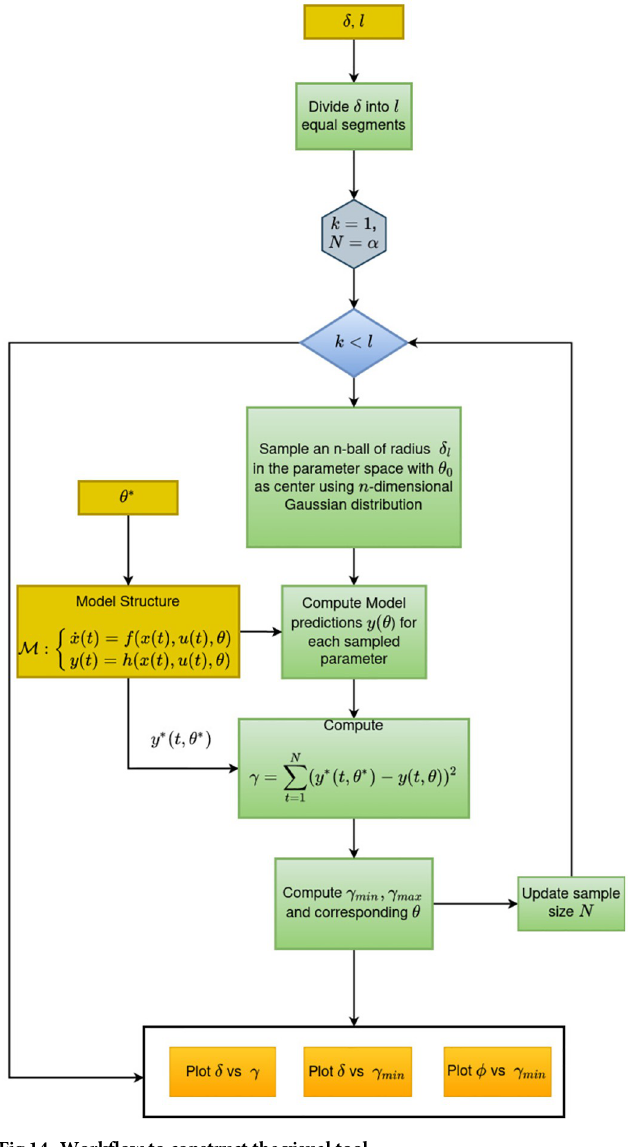
Fig 14. Workflow to construct the visual